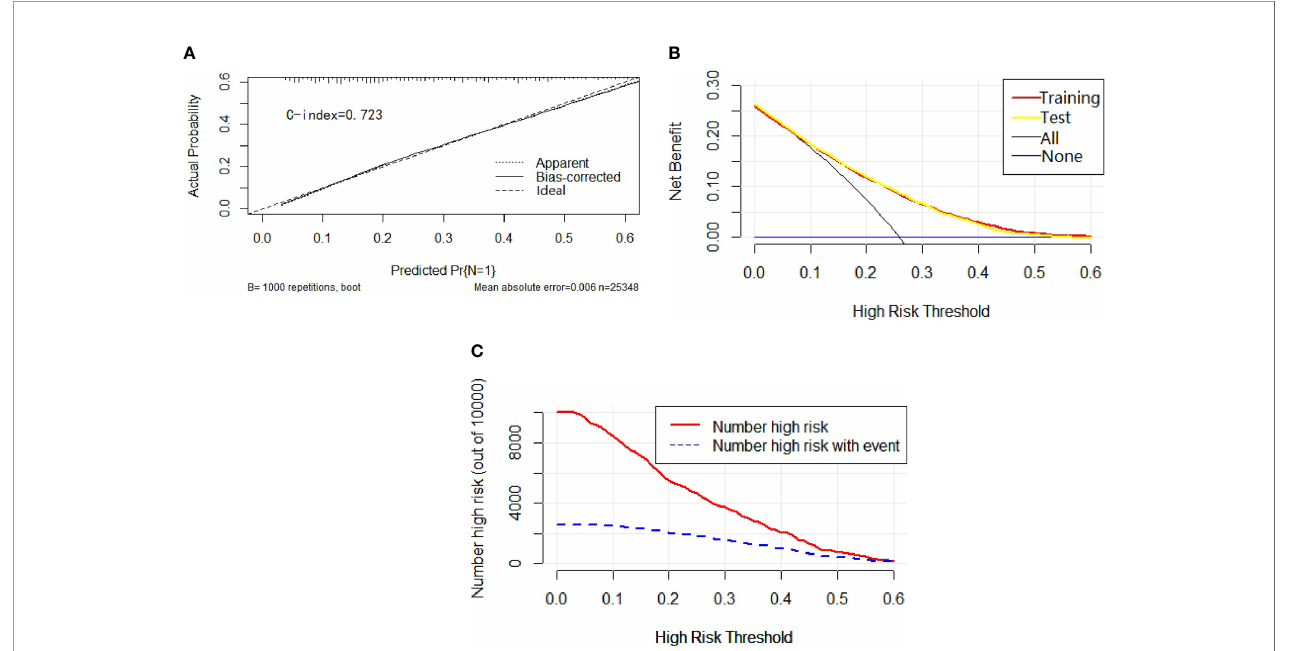
FIGURE 4 | In calibration curve (A) , the x-axis represents the predicted probability of LNM, the y-axis refers to the actual probability of LNM, and the ideal line marks the diagonal of the graph, indicating that the predicted probability is utterly equal to the true likelihood, which is the ideal condition of the prediction model. The apparent line represents the theoretical prediction ability, and the bias-corrected stands for the prediction ability of the corrected model. The fi gure shows that the above three lines are very close, and c-index = 0.723, suggesting that the prediction model is very accurate. In the decision curve (B) , the x-axis represents the threshold probability, the y-axis marks the net income, the horizontal blue line is an extreme case that no patients suffer from LNM, and the black line represents another extreme case that all patients have LNM. The red line and the yellow line are predicted by the training group and the test group, respectively. The two lines basically coincide, indicating that the prediction ability of the model is stable and reliable. In the clinical impact curve (C) , the x-axis represents the different thresholds of LNM, and the y-axis stands for the number of people. The red line displays the number of high-risk patients under different thresholds, and the blue line illustrates the actual number of LNM in high-risk patients under different